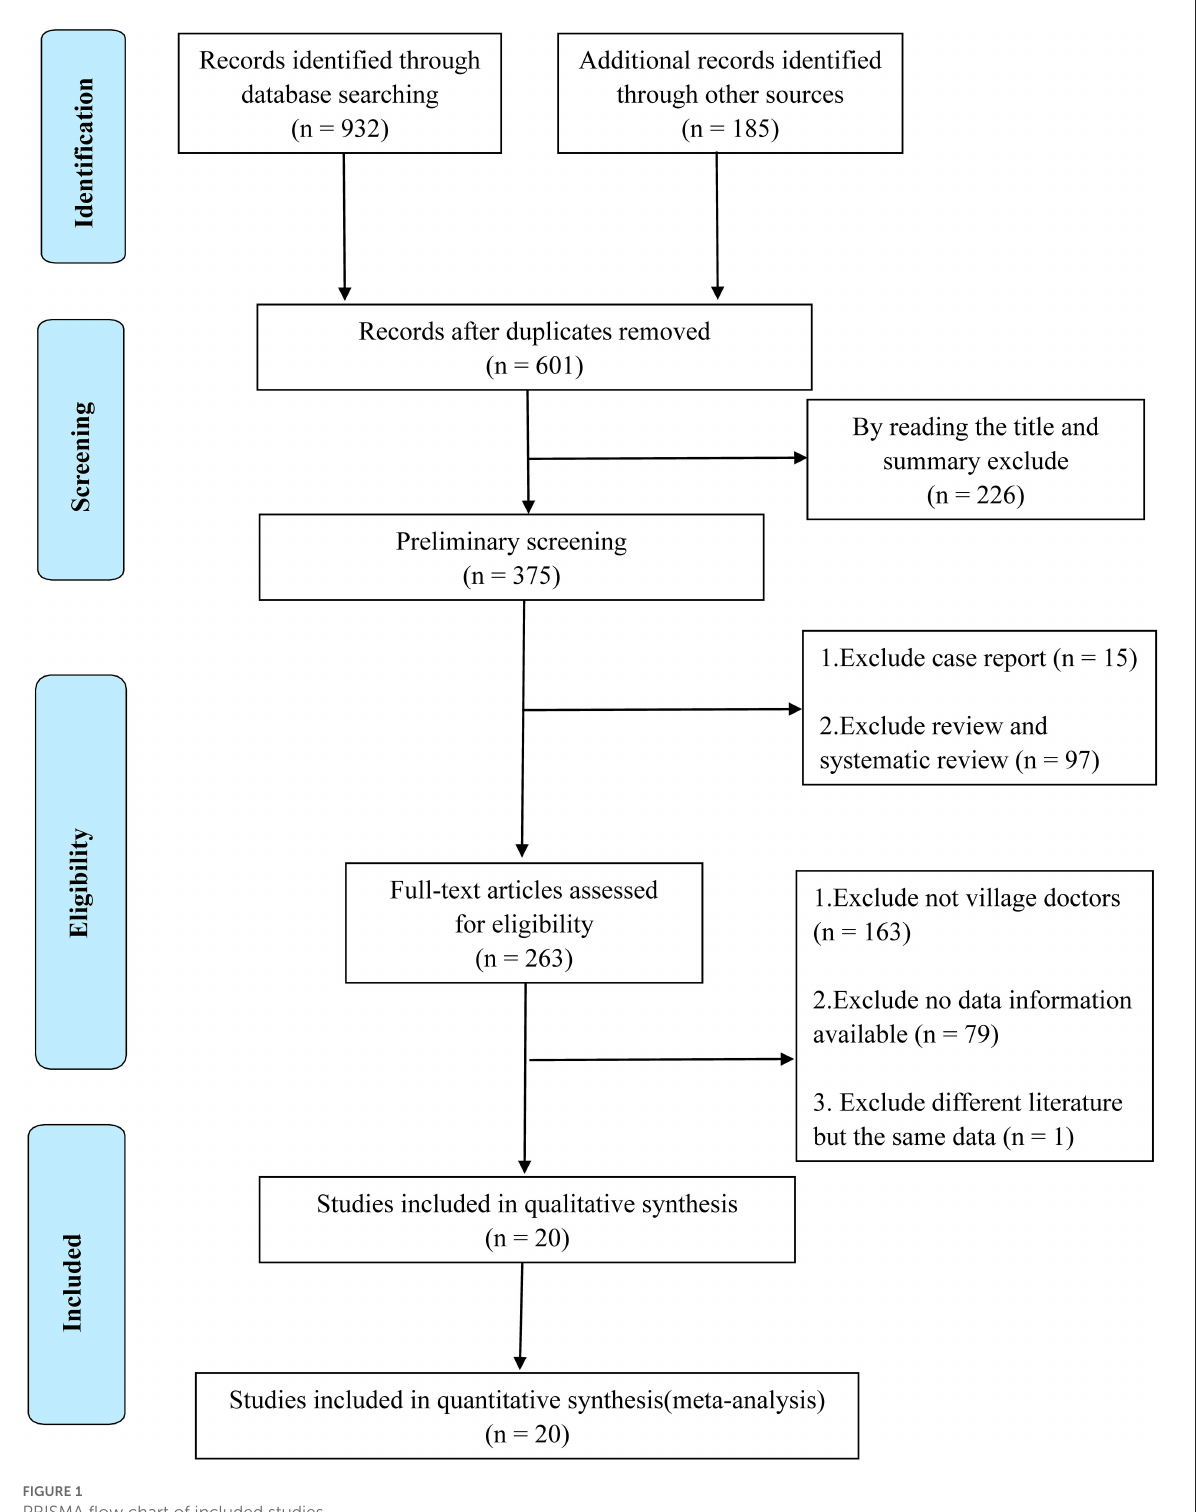
FIGURE1 PRISMA flow chart of included